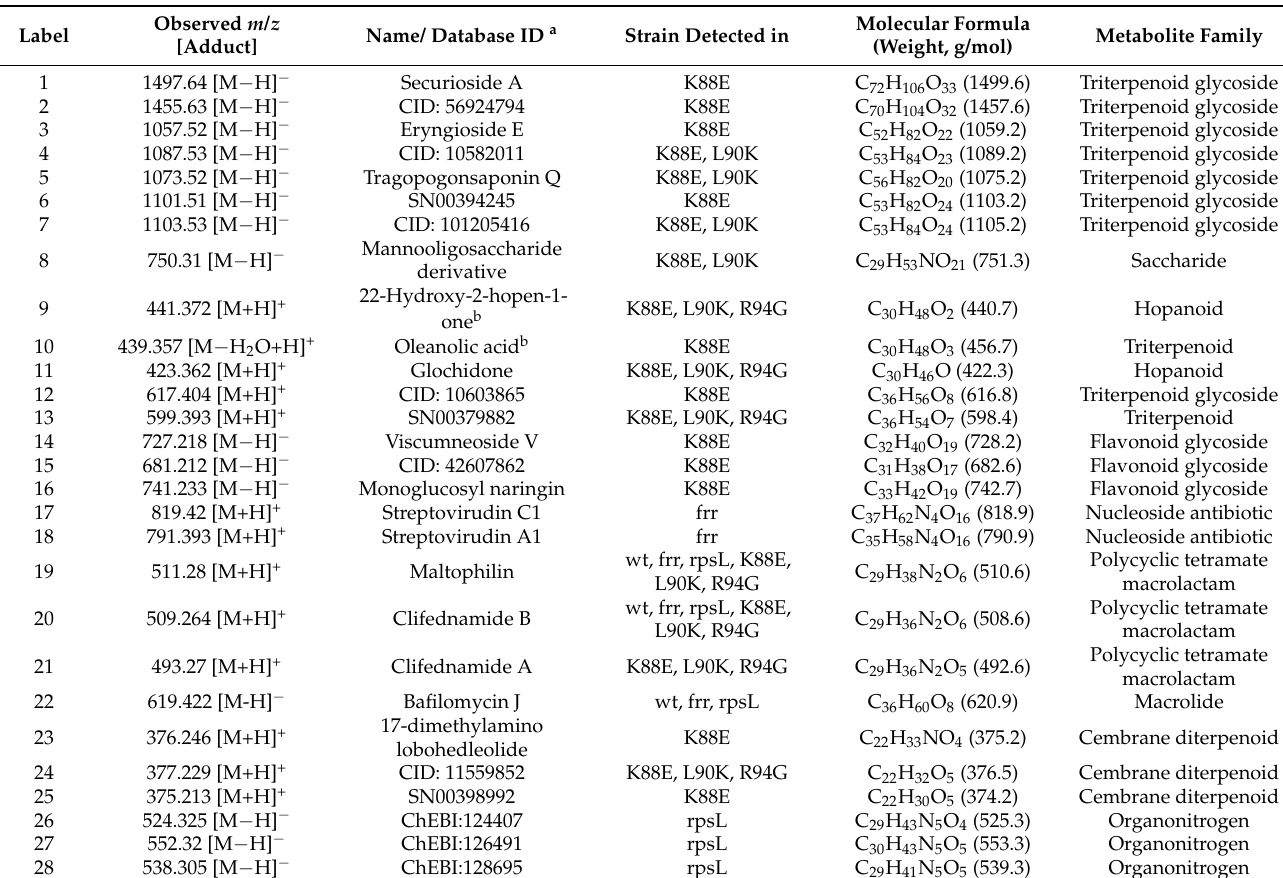
Table 2. In silico annotation of metabolites produced by wild-type (wt) S. clavuligerus or strains overexpressing frr (frr), rpsL (rpsL), rpsL -K88E (K88E), rpsL -L90K (L90K) and rpsL -R94G